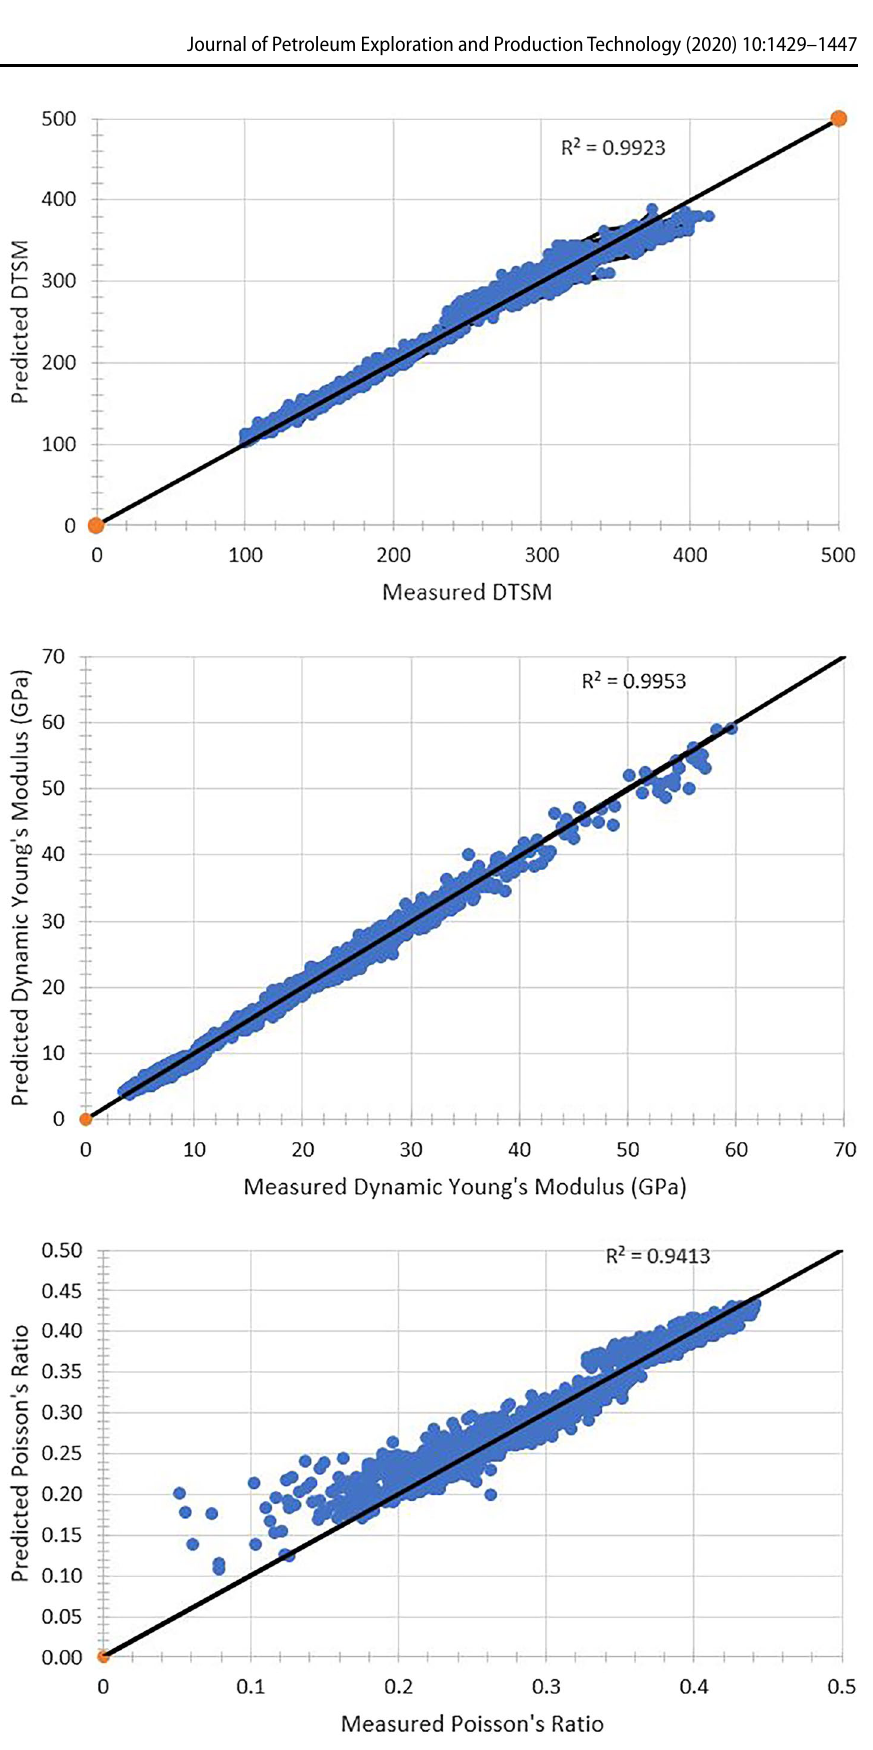
Fig. 9 Predicted shear wave transit time versus measured shear wave transit